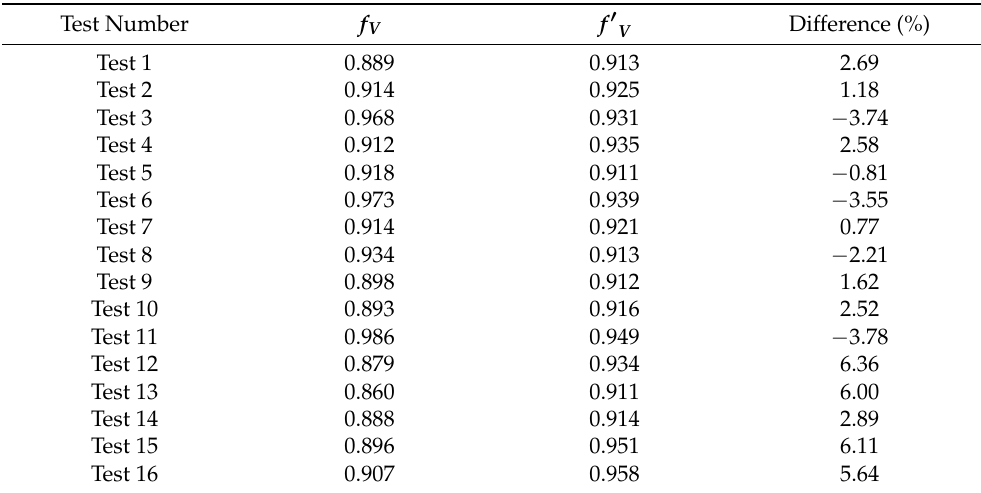
Table 11. Comparison between the reduction factors of vertical stiffness from fitted expressions and finite element